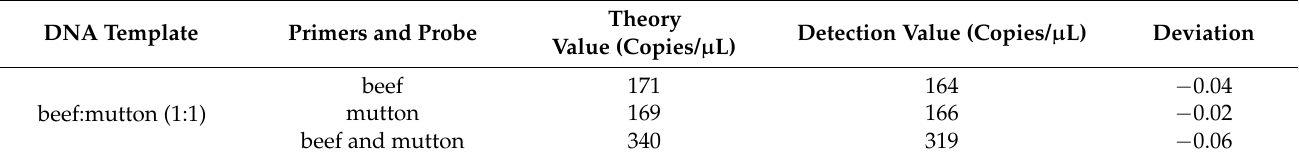
Table 5. Measured values of ddPCR for beef and mutton. DNA Template